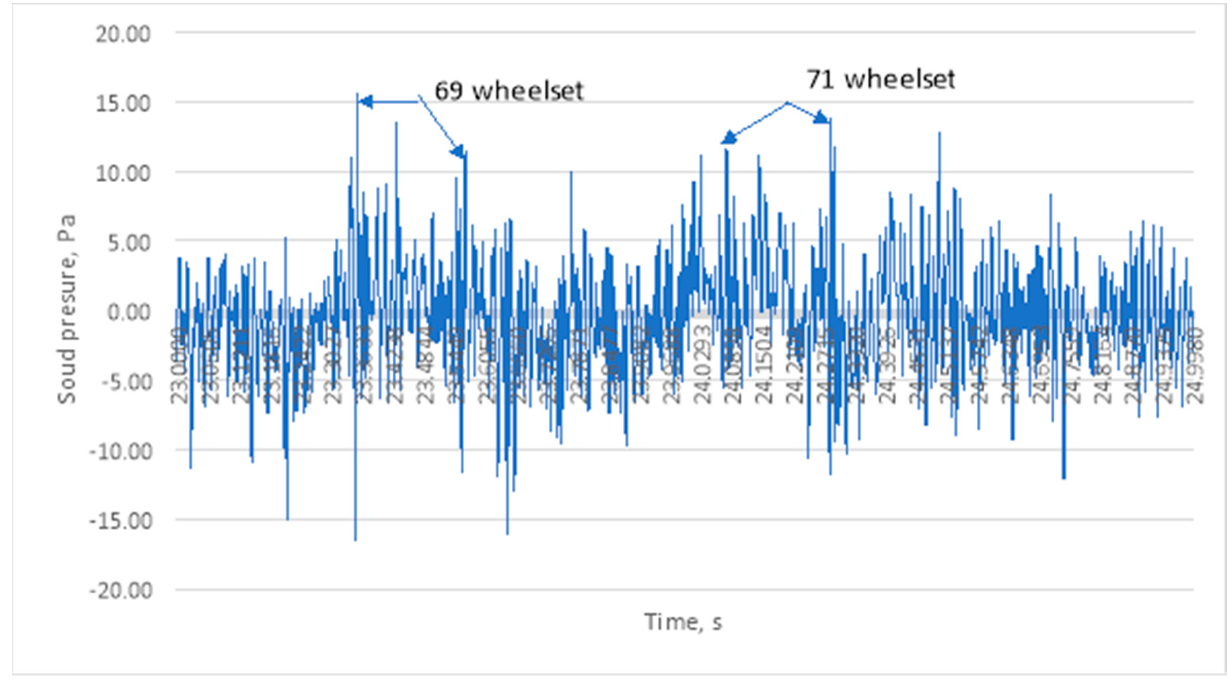
Figure 7. Measured sound pressure of 69 and 71 wheelset failure. Area 1 indicates the defect (Figure 6). Using filters based on possible recorded/detected damage (Table 5), two sound pres- sure peaks (SPP) were detected for each damage. The results are presented in the Table 6.